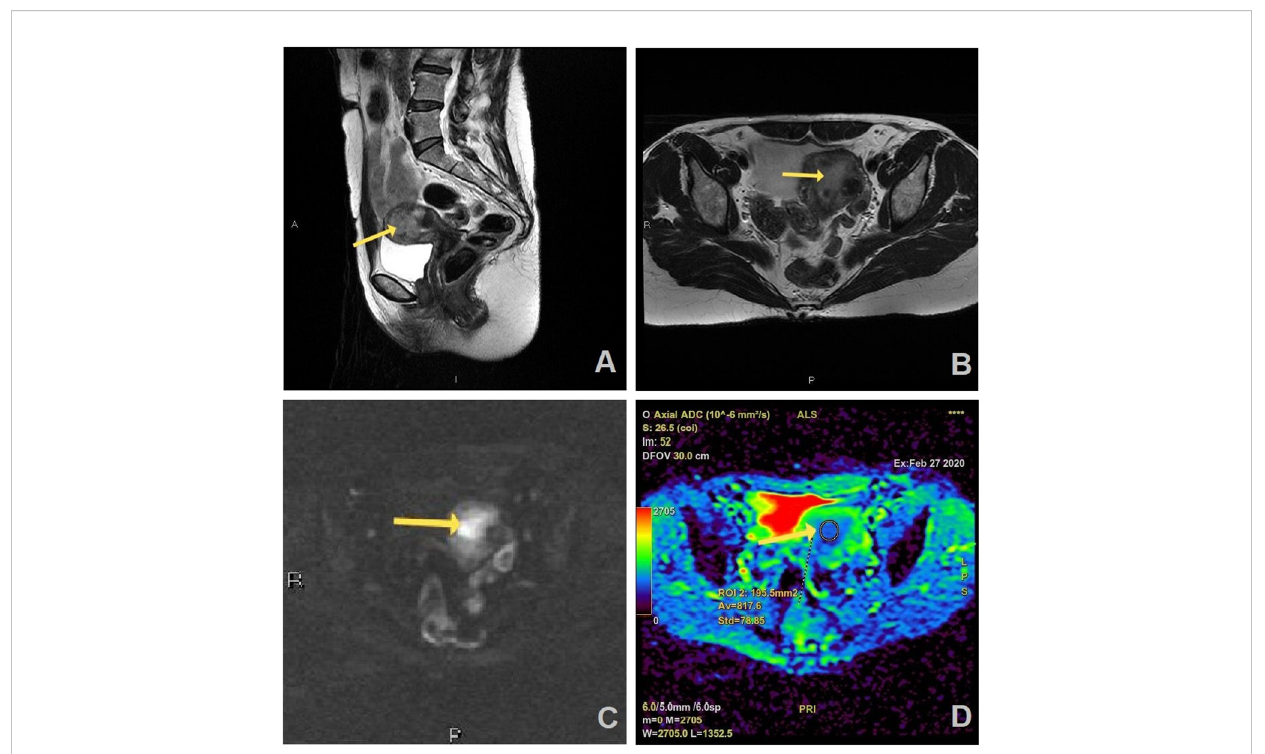
FIGURE 2 MR images of a 55-year old woman with a history of vaginal bleeding, high suspicious EC on MRI, and histopathologically proven endometrial endometrioid carcinoma, HG2 (FIGO stage II): (A) sagittal and (B) axial T2W FR FSE image shows endometrial mass (arrow) in uterine cavity which is hyperintense on axial DWI (b=1200 s/mm 2 ) (C) and has correlation on ADC map with the measured ADC value of 0.817 × 10 − 3 mm 2 /s (D)